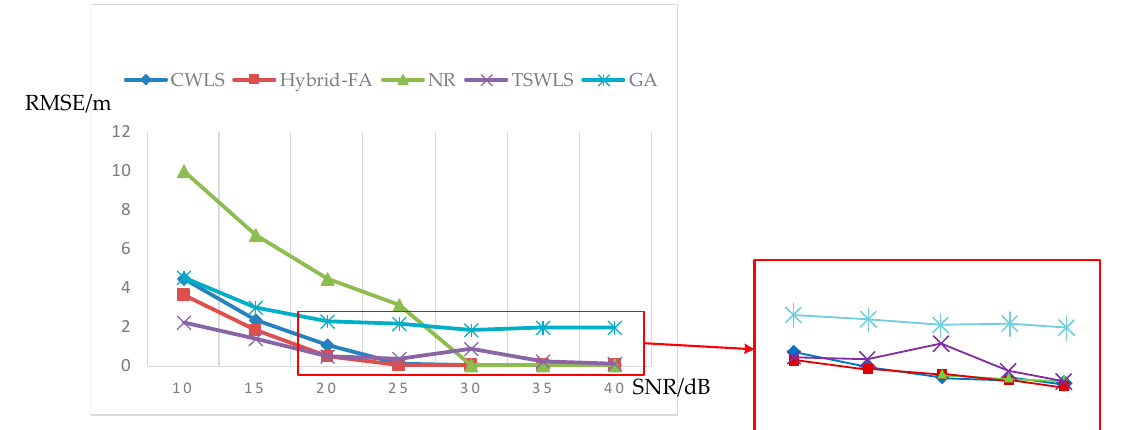
Figure 5. The comparison of the four algorithms for TDoA measurement.